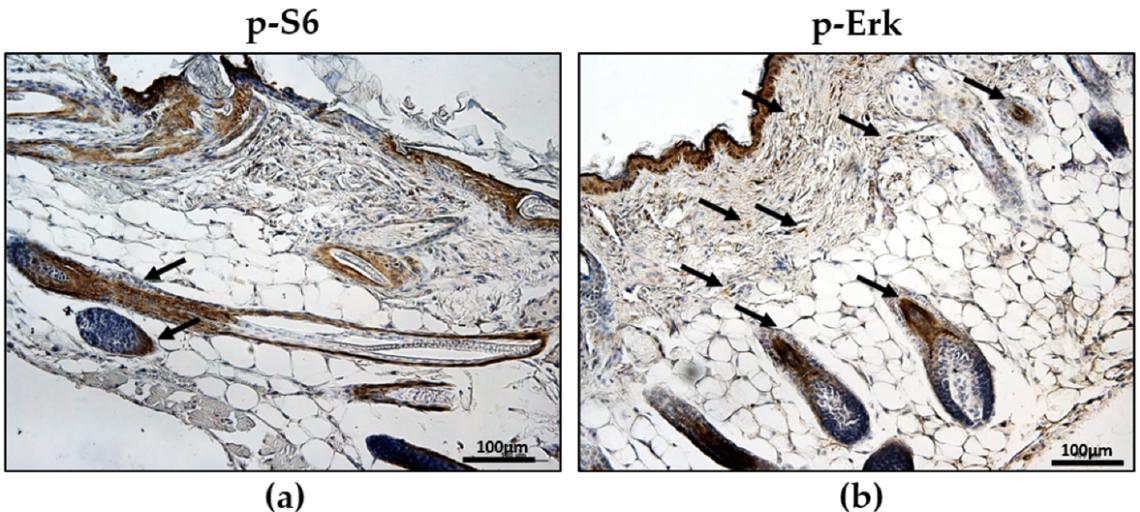
Figure 3. Representative immunohistochemistry for phospho-S6 ( a ) and phospho-Erk ( b ) positivity in the skin of mice injected with tuberin-null cells. Positive cells were stained in brown (highlighted by arrows); nuclei were stained with hematoxylin. Scale bar: 100 µm.